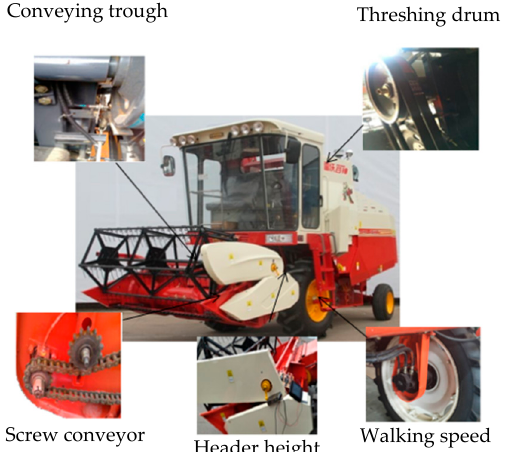
Figure 11. Part of the sensor installation location drawing.